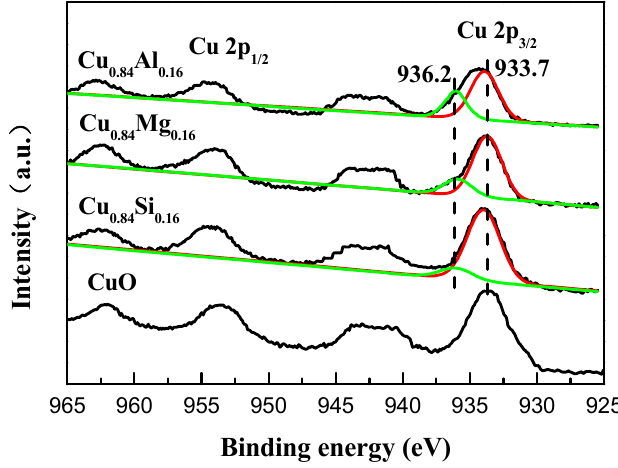
Figure 3. Cu 2p X-ray photoelectron spectroscopy (XPS) spectra of the catalysts.